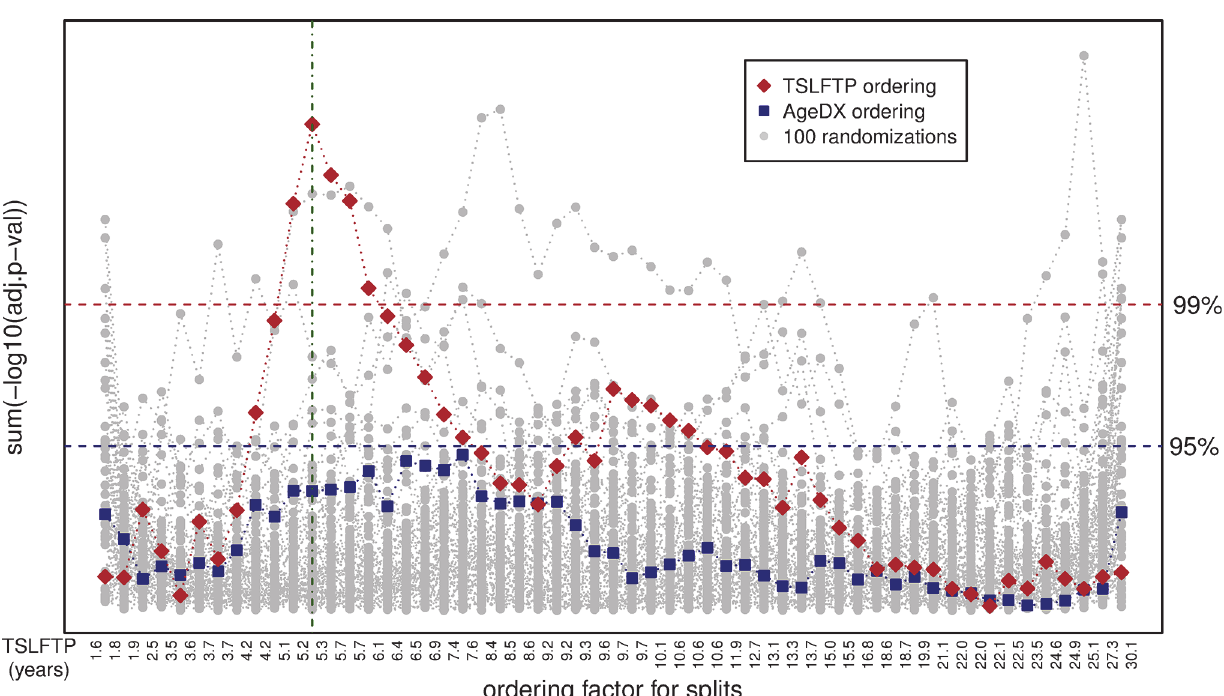
Fig 2. Exhaustive splitting of Ella samples. Natural separation of the samples into two groups based on the time since the last full-term pregnancy (TSLFTP). Exhaustive splitting of the Ella FFPE case series was based either on TSLFTP, on age at diagnosis (AgeDX), or on randomized data. The x-axis represents individual splits based on each ordering factor. The y-axis represents the level of difference between the groups (sum of the negative log base 10 of the adjusted p-value) for each split. The red diamonds represent the differences after ordering based on TSLFTP. The TSLFTP for individual samples for this ordering is displayed at the bottom. The blue squares are based on ordering by AgeDX. Grey dots represent 100 randomized orderings. Blue and red horizontal dashed lines show the 95th and 99th percentile of the randomized data. Green vertical line indicates the split point with the largest difference between the groups based on TSLFTP.